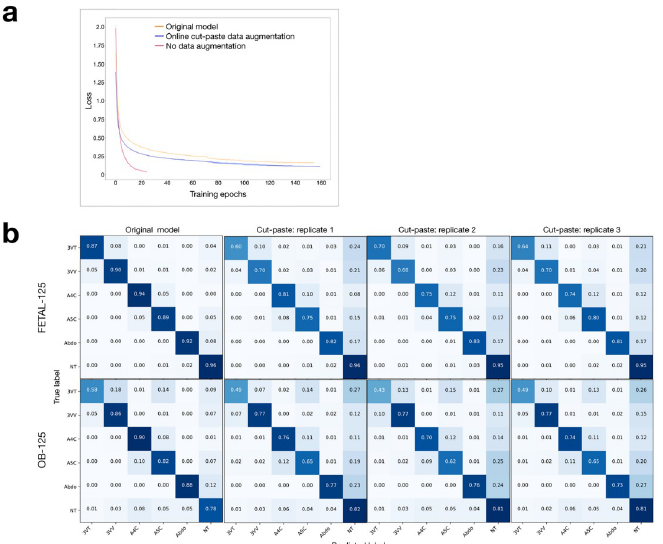
Fig 2. Cut-paste as a data augmentation strategy. (a) Loss plots for original training (yellow), training with no online data augmentation (red, with error as light red), and training with online cut-paste data augmentation (blue, with error as light blue). (b) Normalized confusion matrices of FETAL-125 and OB-125 test data, for original model and model trained with online cut-paste data augmentation (three replicates